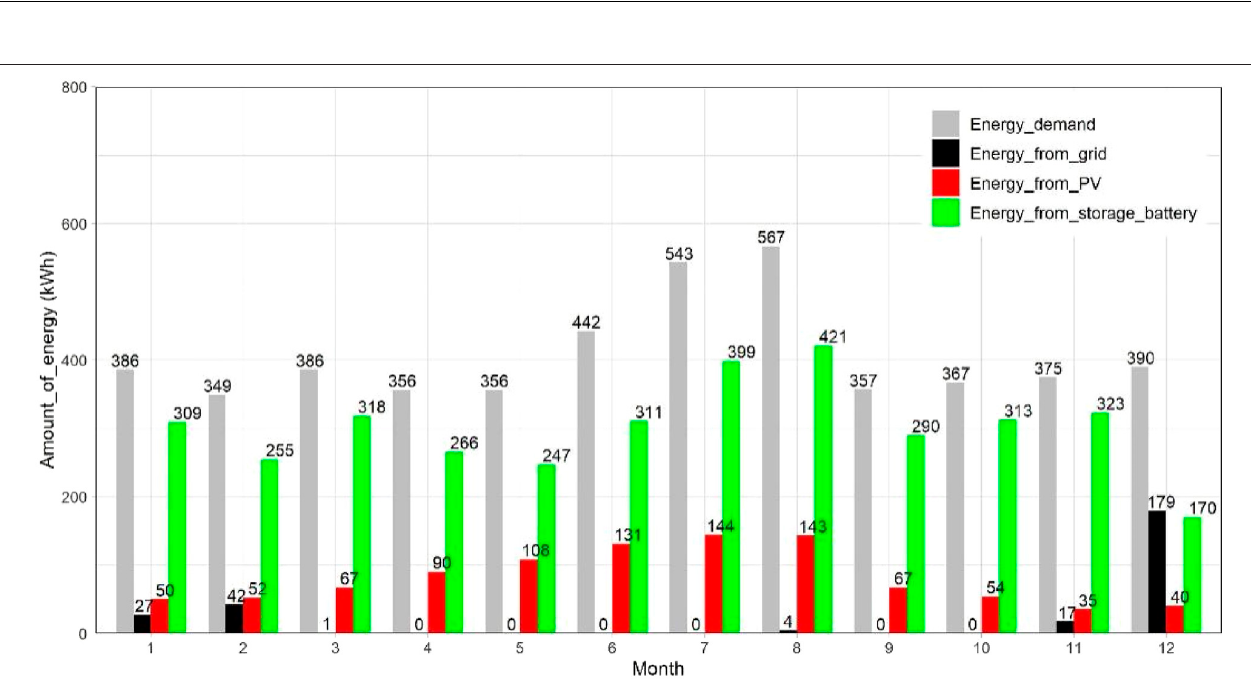
Frontiers in Energy Research |